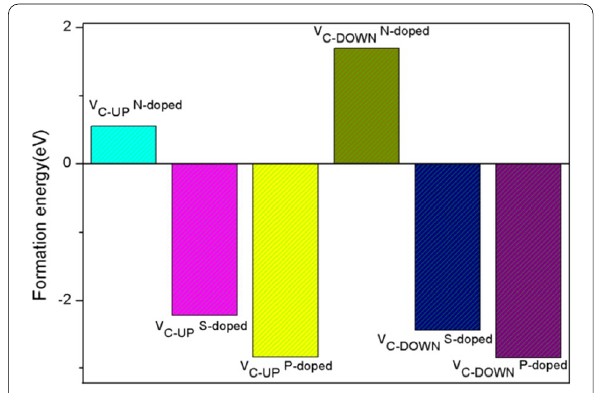
Fig. 4 Formation energy of two initial defect and doped PG structures with C1 active sites for HER, more negative value indicates higher stability of the